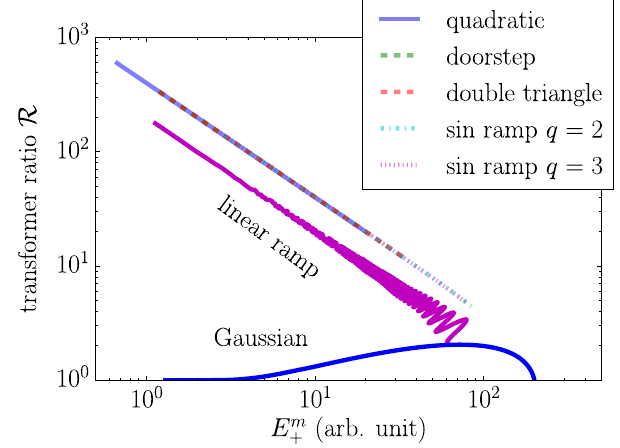
FIG. 3. Tradeoff curves between R and E m profiles listed in Table I. The “ quadratic ” and “ sin ramps ” respectively correspond to the distributions proposed in Secs. II B and II A. The Gaussian and ramp distributions are displayed for